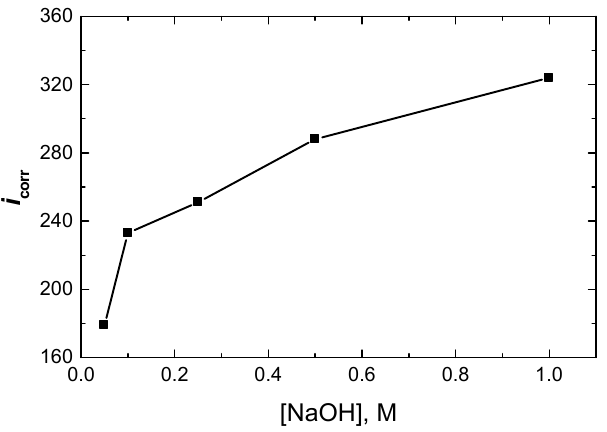
Table 1. Values of PDP parameters for Al corrosion in different [NaOH] at 298 K.